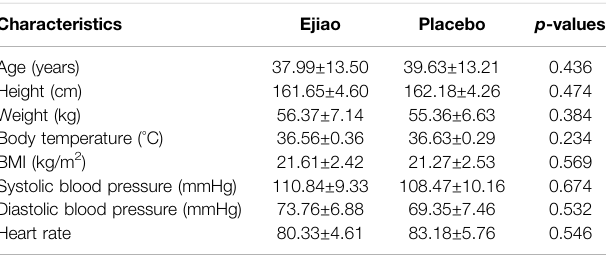
TABLE 1 | Baseline characteristics of the study participants.